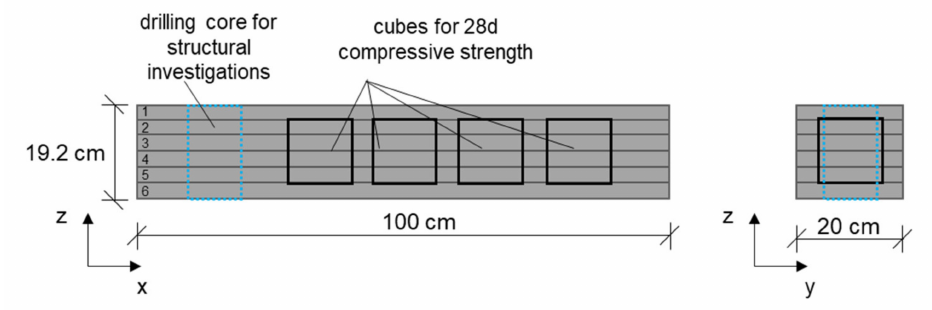
Figure 3. Principle of sampling in the material